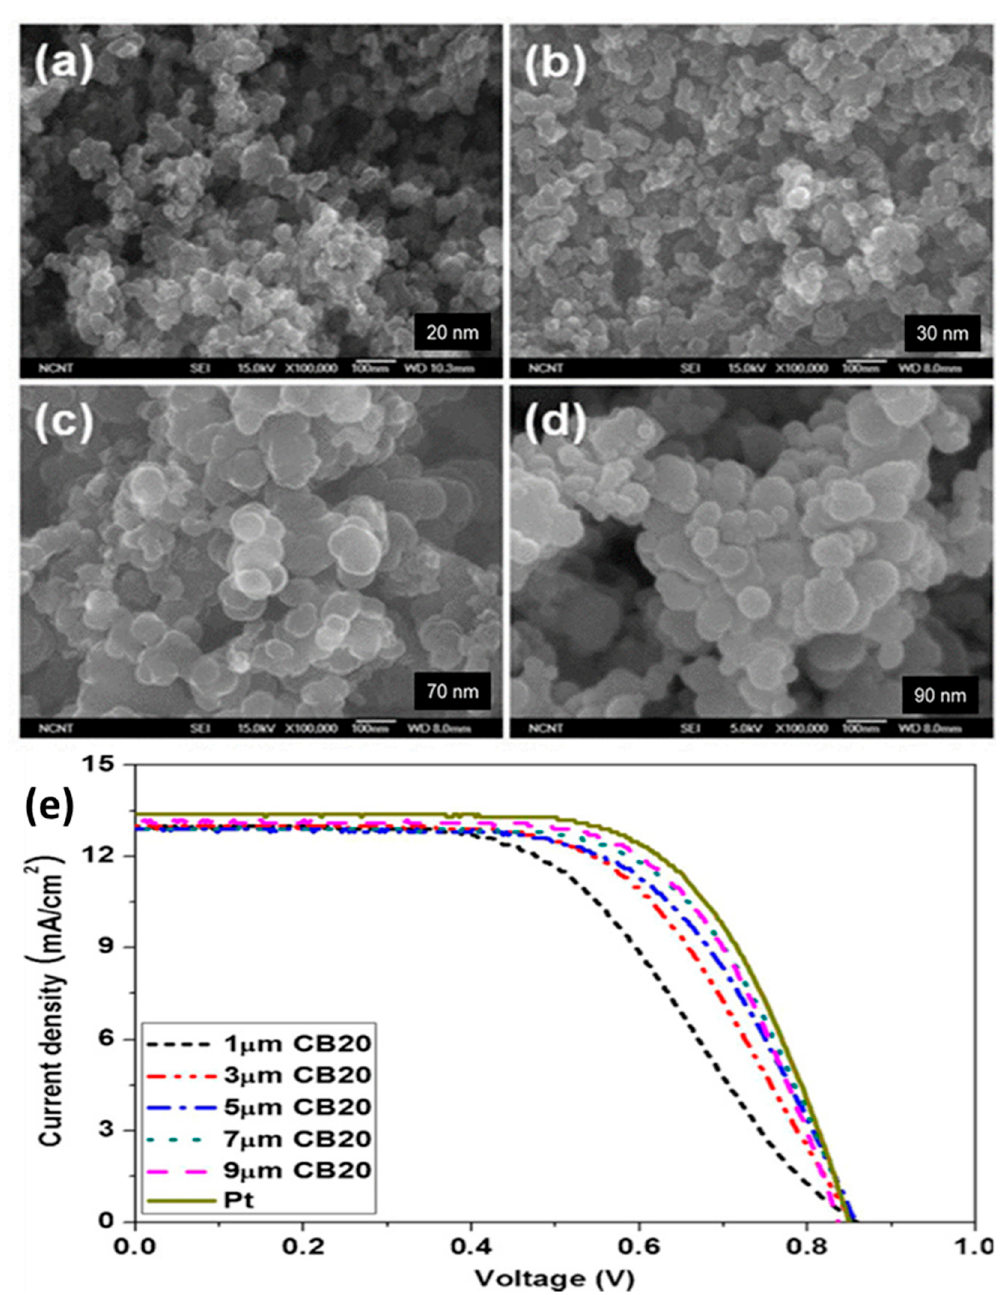
Figure 8. SEM morphologies of CB layers with various particle sizes of ( a ) 20, ( b ) 30, ( c ) 70, and ( d ) 90 nm, ( e ) Photocurrent-voltage curves for CB20 and Pt-CE-based DSSCs. Reprinted with permission from Reference [51].